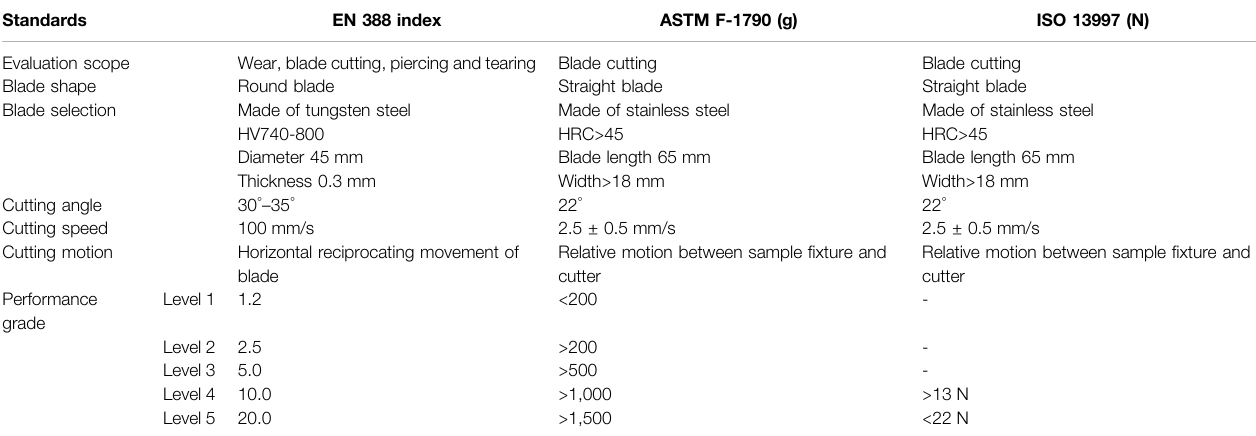
TABLE 2 | Comparison of three anti-cutting evaluation standards.